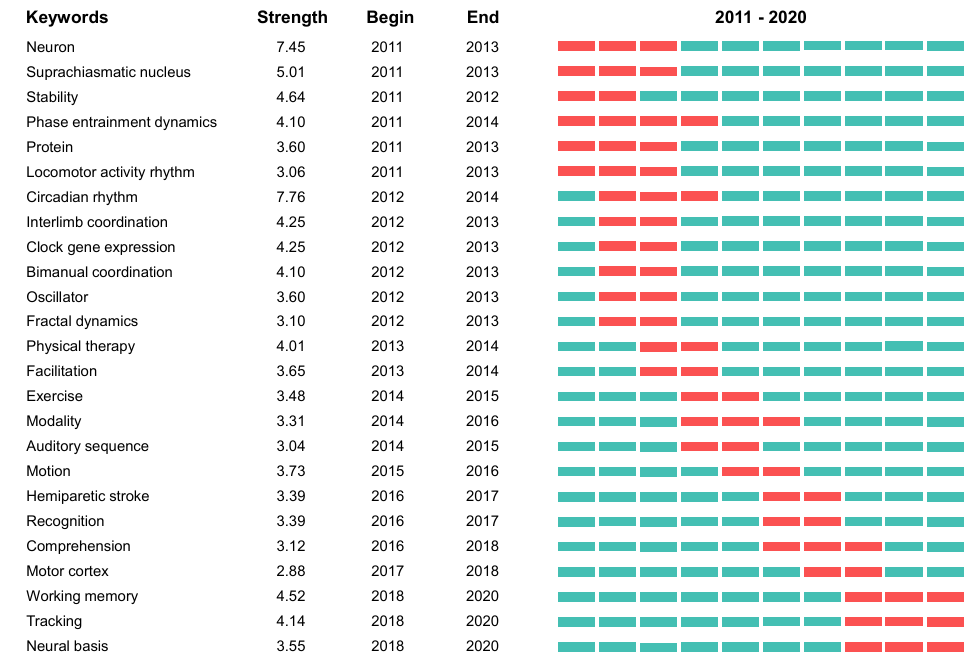
Figure 5. Keywords with the strongest citation bursts of publications on rhythmic auditory stimu- lation research. Alt text: The top 25 keywords with the strongest citation bursts of publications on rhythmic auditory stimulation research among 2011–2020. Working memory, tracking, and neural basis were the most recent three.